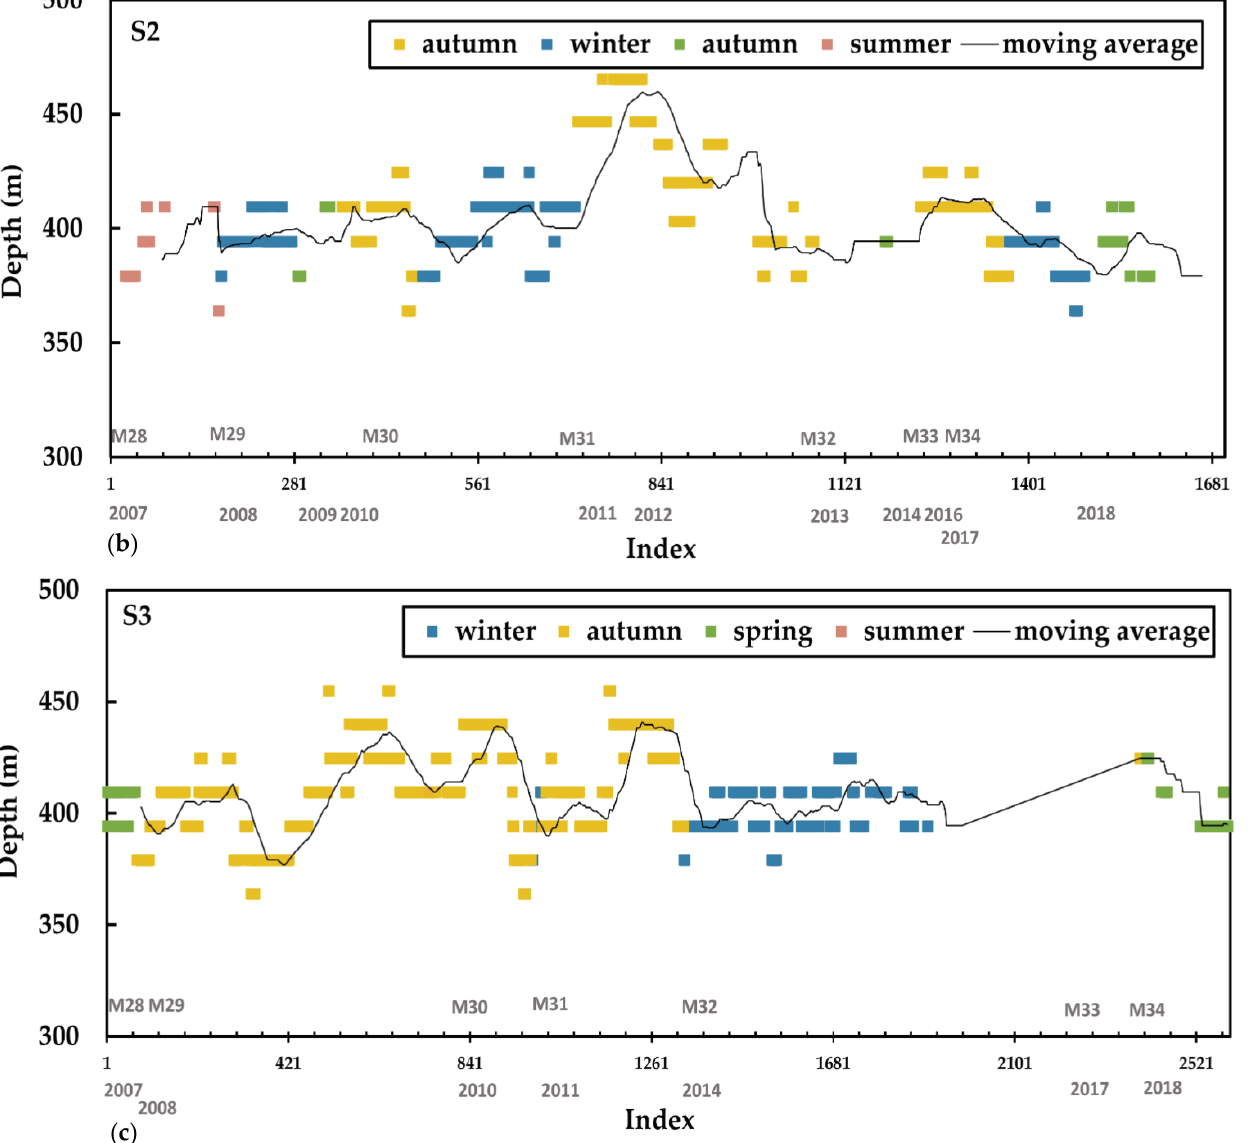
Figure 11. The thickness variations of shallow deposits through 11 terrestrial years (observation period is from 2007 to 2018, the Martian year is M28–M34) in the study area of ( a ) S1, ( b ) S2, ( c ) S3. The horizontal axis presents the index of the SHARAD orbit ordered by the observation time, and the vertical axis shows the thickness of AA 3C . Moving average is the trend line with a period of 80.